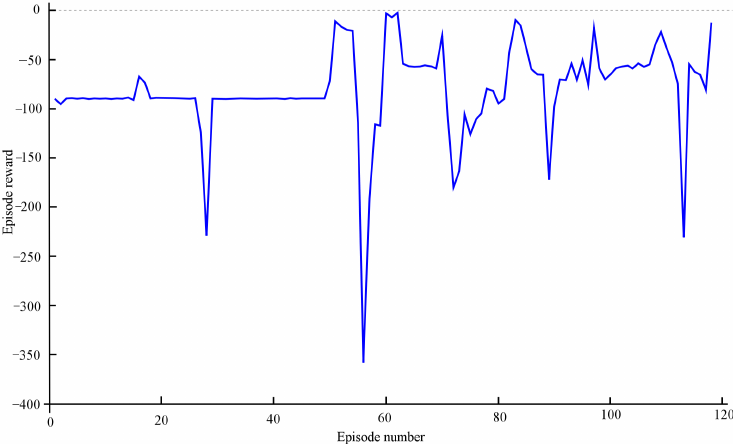
Figure 3. Illustration of the cumulative reward